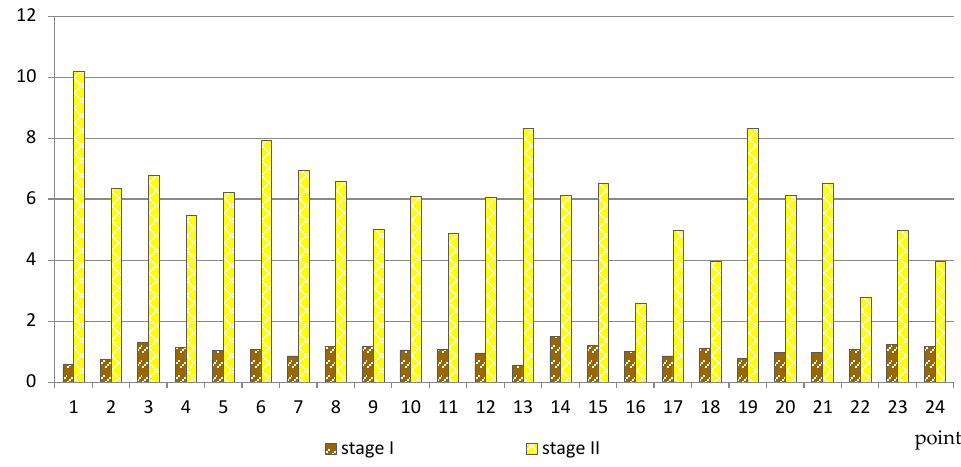
Figure 3. Corrosion current density measured on the reinforcement in C_I_a specimens. In the second group of Portland cement specimens, C_I_n (Figure 4), in which no air-entraining agent was used, the limit values of the results were similar to those obtained in specimens C_I_a (from i cor = 2.82 μ A/cm 2 to i cor = 9.87 μ A/cm 2 ), but the results were more dispersive and there were more results with lower values than for the C_I_a